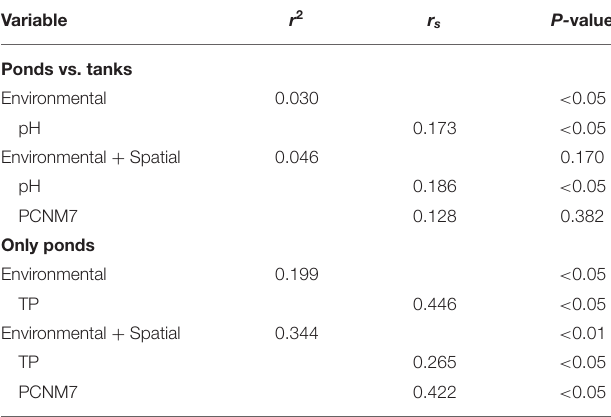
TABLE 4 | Multiple regression models (MRM) revealing the partial contribution of the spatial descriptors (PCNMs) and the explanatory variables to the dissimilarity in the macroinvertebrate assemblages, between ponds and tanks (Ponds vs. tanks), but also among the ponds alone (Only ponds). Variable P- value Ponds vs.